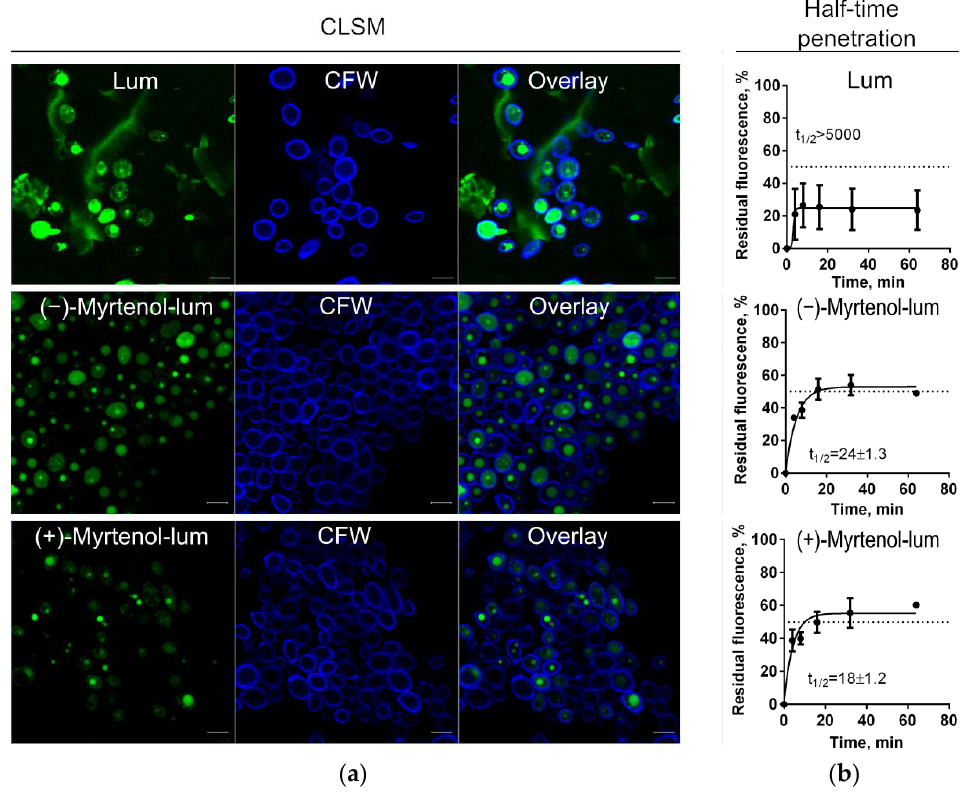
Figure 5. Myrtenol-lum penetration into C. albicans cells. (a) The localization of either ( − )-myrtenol or (+)-myrtenol carrying the fluorophore BODIPY (myrtenol-lum) assessed by confocal laser scanning microscopy. The solely fluorophore (lum) and Calcofluor-White (CFW) membrane dyes served as references. (b) Penetration of myrtenol-lum into C. albicans cells. Myrtenol-lum was added to C. albicans cells, and the sole fluorophore (lum) was used as a control. After 4, 8, 16, 32, and 64 min of incubation, cells were harvested, washed with PBS, and residual fluorescence was measured. The half-time of penetration (t½ ) was 24±1.3 min and 18±1.2 min for ( − )-myrtenol and (+)-myrtenol, respectively, while for the fluorophore solely (lum) was t 1 2